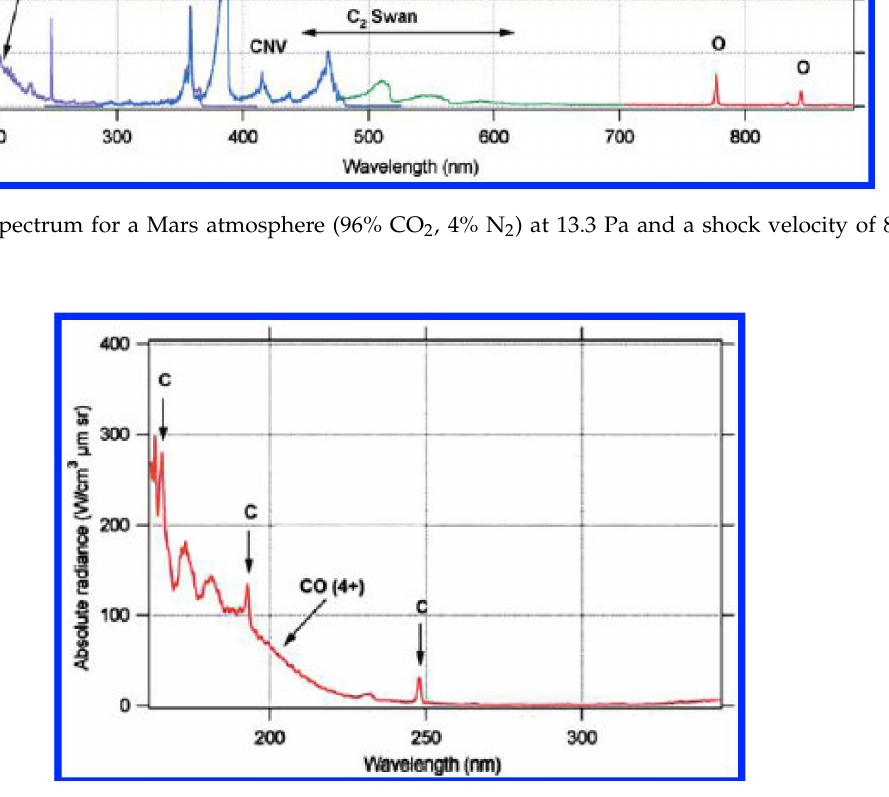
Figure 18. VUV part of the radiance spectrum for Mars at 0.1 Torr (13.3 Pa) and 8.6 km/s (from